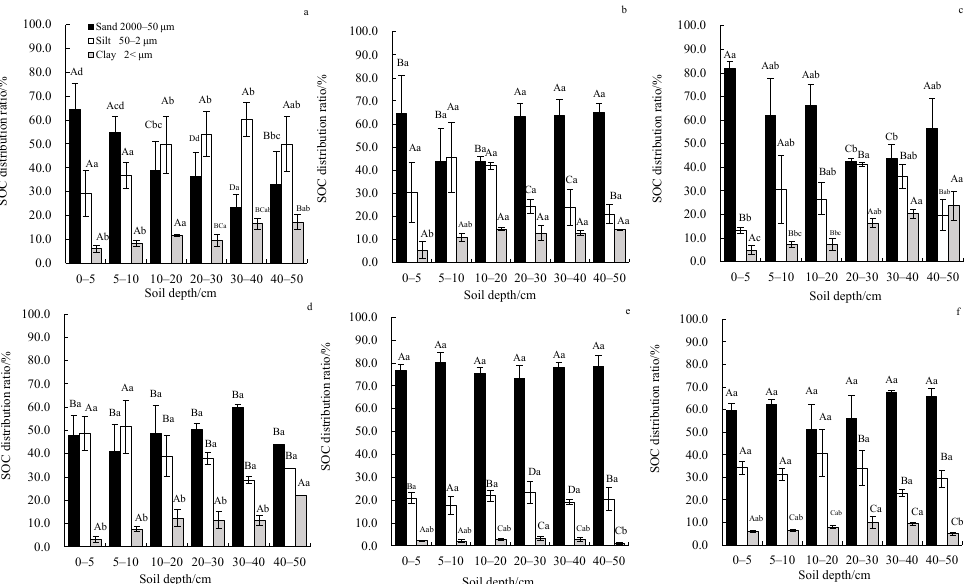
Figure 5. SOC distribution ratio of grasslands in different restoration years. (( a – f ) in the figure represent restoration 4a, 5a, 6a, 7a, 8a, and 9a, respectively), Notes: The lowercase letters in the figures represent significant differences in the same component at different depths ( p < 0.05), and the uppercase letters indicate significant differences in the same component at the same depth in different restoration years ( p < 0.05).